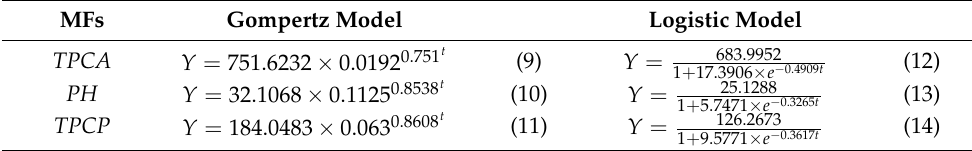
Table 1. The Gompertz and Logistic prediction models for TPCA , PH and TPCP